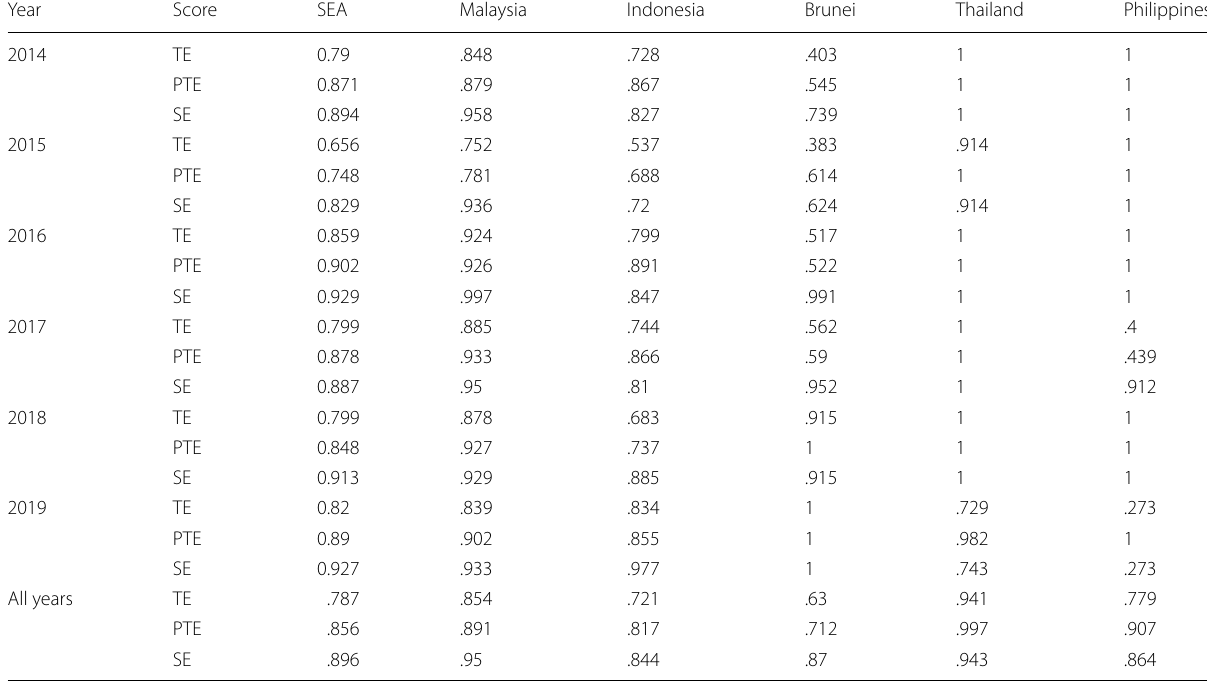
Table 2 Average efficiency (TE, PTE, SE)